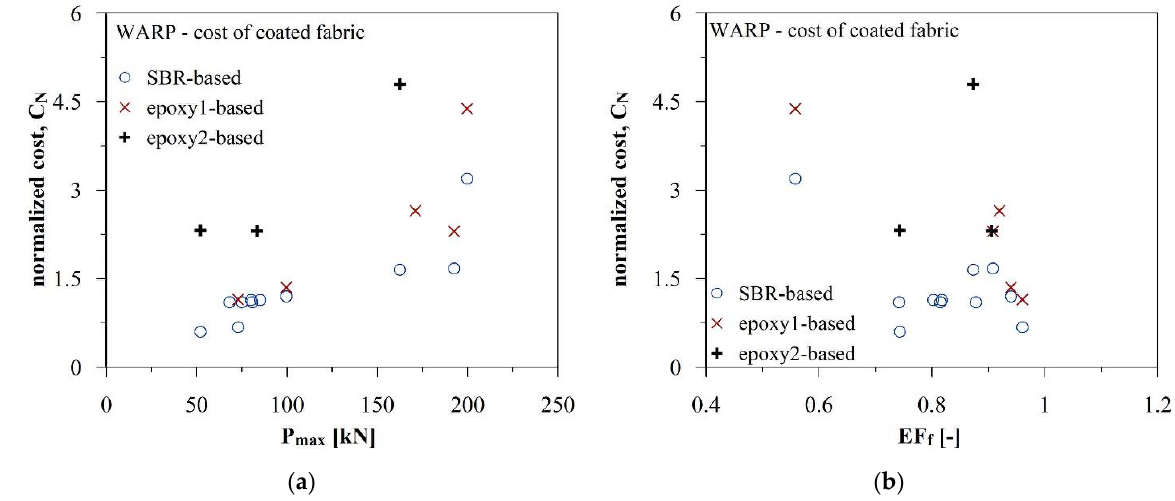
Figure 11. Normalized cost, C N , vs. average maximum tensile load ( a ) and fabric efficiency ( b ) in the warp direction.